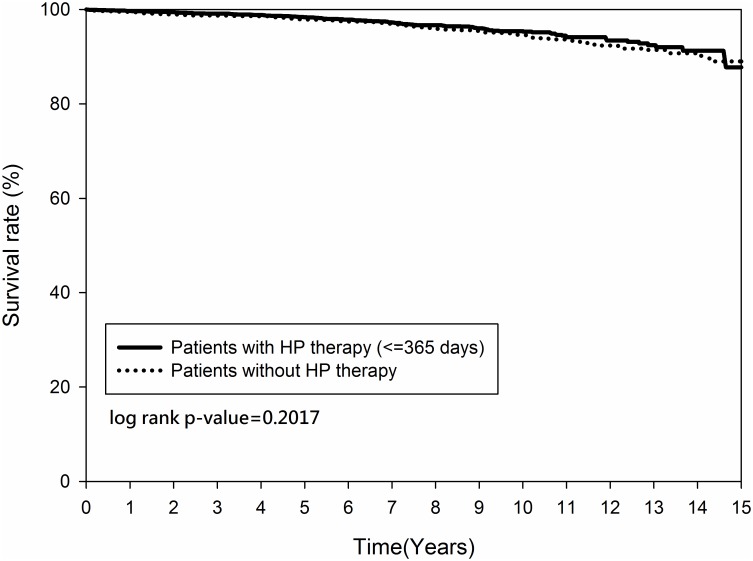
Kaplan-Meier curve for mortality rate between patients with and without Helicobacter pylori therapy.